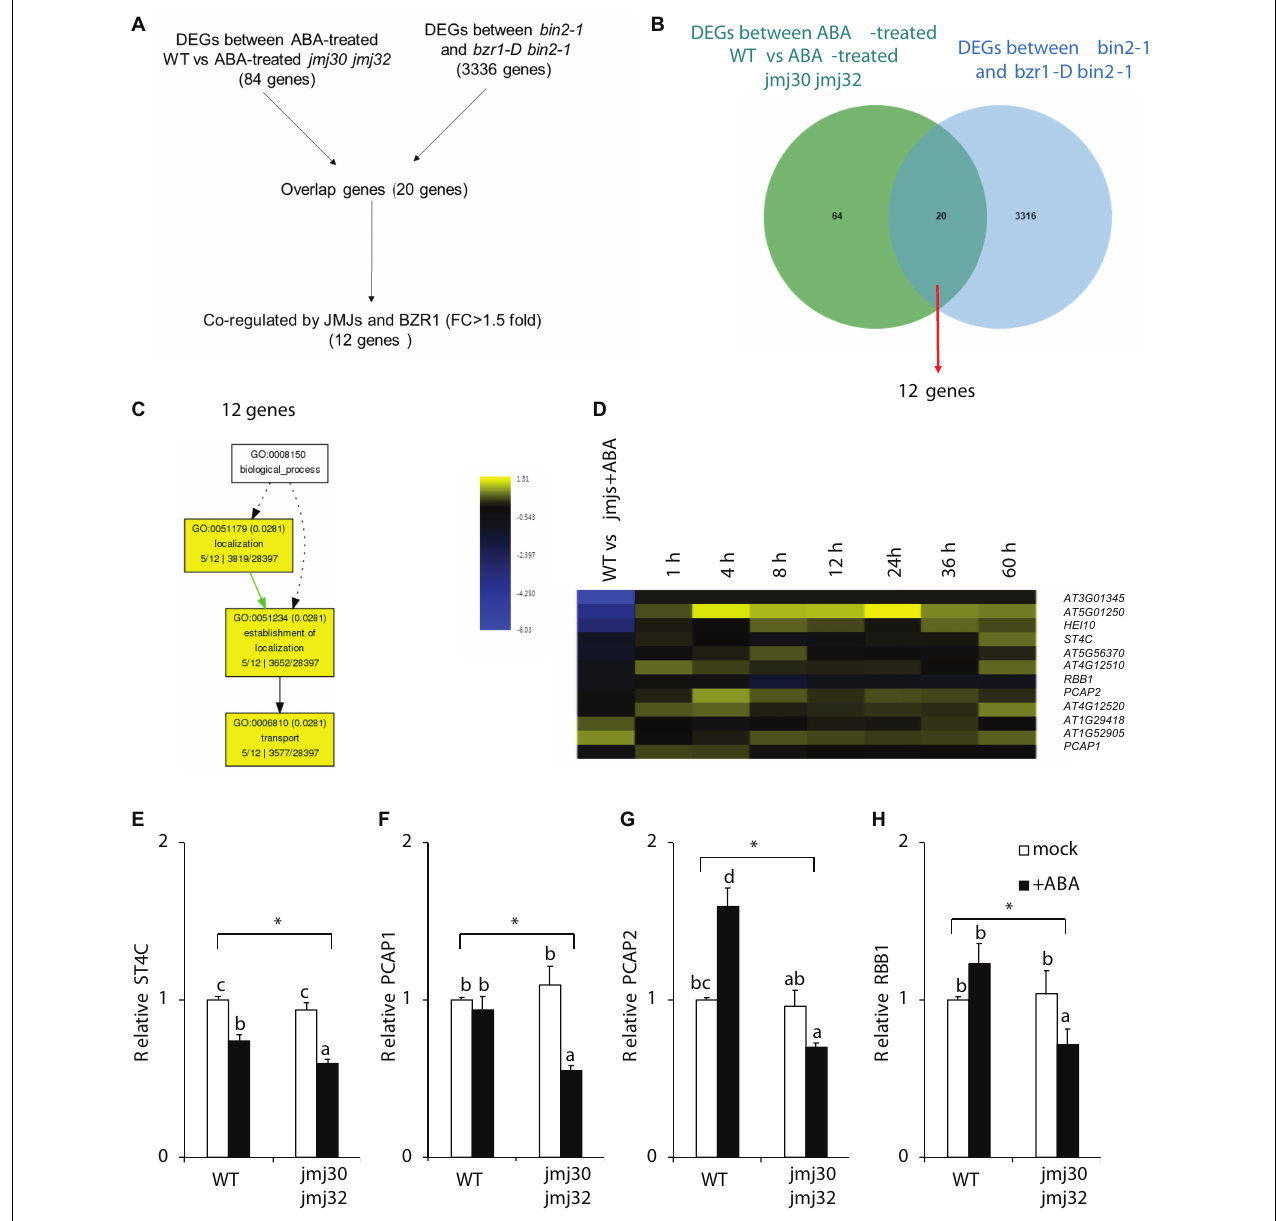
FIGURE 5 | JMJs and BZR1 coordinately regulate transport-related genes. (A) The flowchart of candidate genes selection. (B) Venn diagram showing the number of genes differentially expressed in ABA-treated wild type (WT) and jmj30-2 jmj32-1 , and the number of genes differentially expressed in bin2-1 and bzr1-D bin2-1 plants. (C) GO analysis among 12 co-regulated genes. (D) Heatmap displaying the log 2 FC (fold change) of the 12 candidates based on two transcriptome datasets. (E–H) Representative genes in wild-type and jmj30 - 2 jmj32 - 1 plants with and without ABA by RT-qPCR: (E) ST4C , (F) PCAP1 , (G) PCAP2 , and (H) RBB1 . Asterisks indicate significant differences based on a one-way ANOVA test. p < 0.05. Different letters indicate significant differences, whereas same letters indicate non-significant differences based on a post hoc Tukey’s HSD test. p <